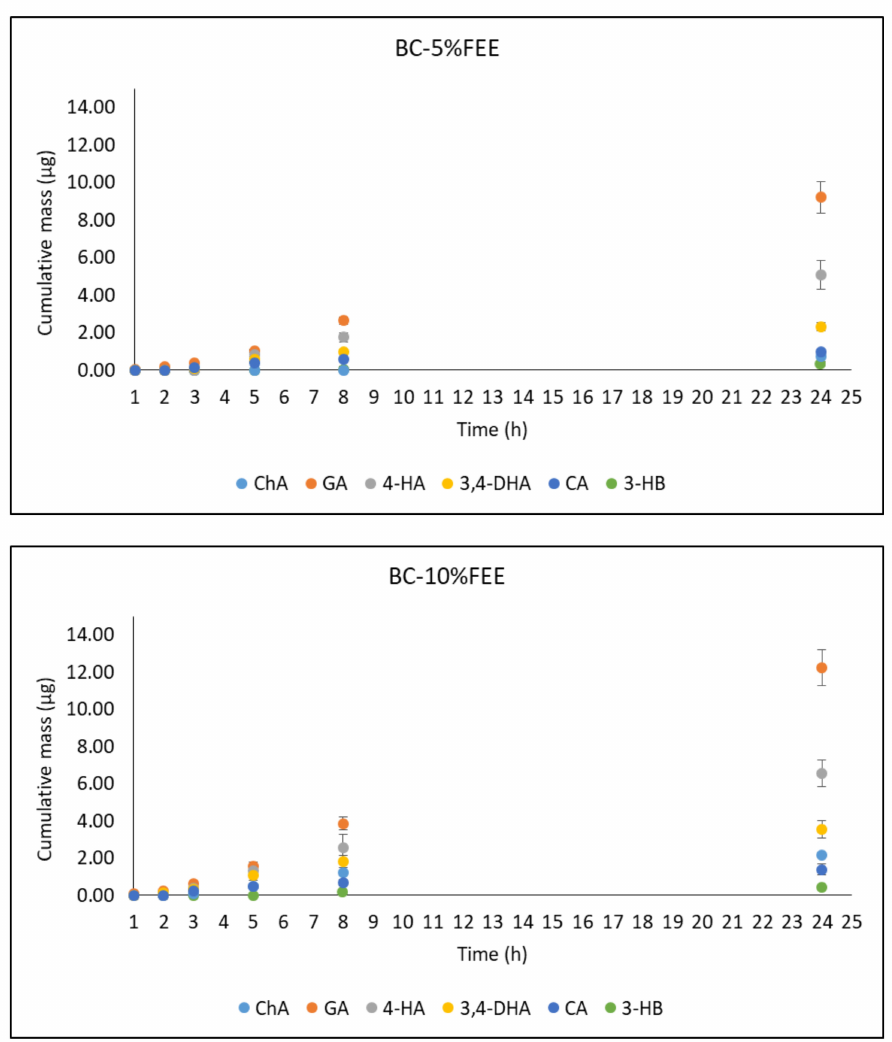
Figure 8. The cumulative mass of phenolic acids in the acceptor fluid during the 24 h penetration. Vertical lines present standard deviation. n =